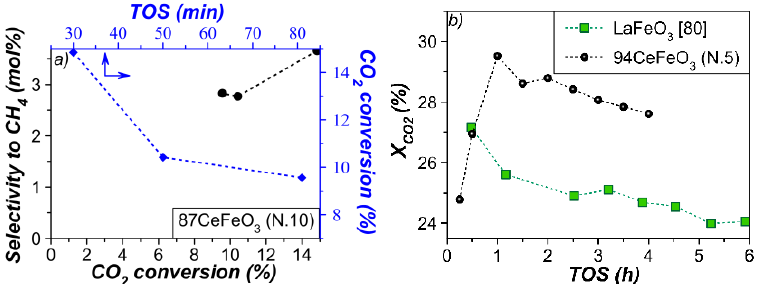
Figure 10. Dependence of CO 2 conversion and selectivity to CH 4 on time-on-stream (TOS) at ( a ) 400 °C, H 2 :CO 2 :N 2 = 3:1:1, WHSV = 10,000 mL·g – 1 ·h – 1 ; and ( b ) 600 °C, H 2 :CO 2 :N 2 = 1:1:1, WHSV = 72,000 mL·g – 1 ·h – 1 .